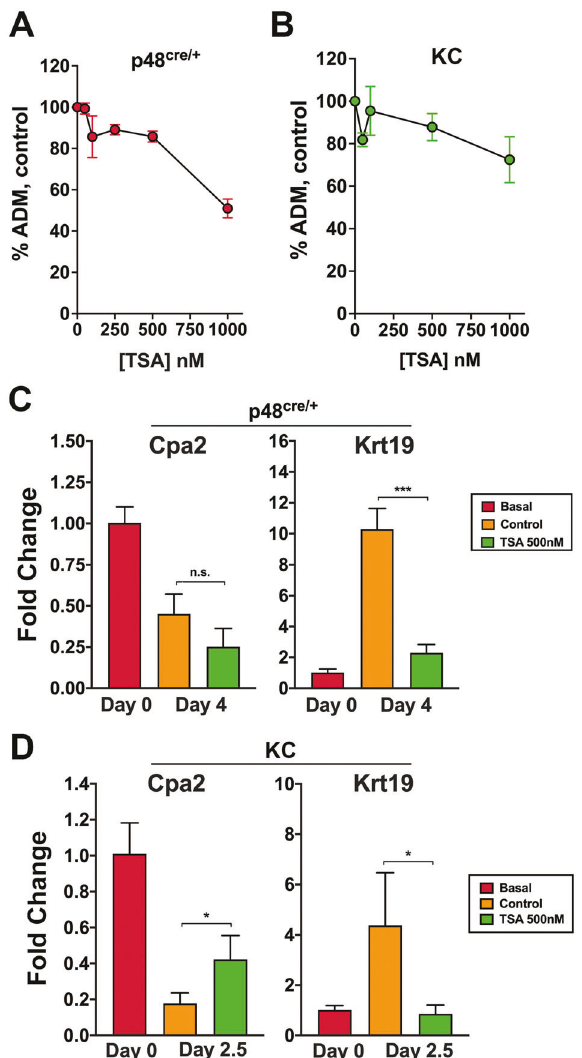
Fig. 2 The HDAC inhibitor TSA attenuates ADM. p48 Cre/ + ( A ) and KC ( B ) primary mouse pancreatic acini were treated with TSA for 3 and 2 days, respectively, and the amount of ADM was calculated microscopically. p48 Cre/ + ( C ) and KC ( D ) acinar cultures were exposed to 500 nM TSA or untreated control for 3 and 2 days, respectively, and the expression of Cpa2 and Krt19 was determined using qRT-PCR. Mean ± SD from triplicate treatments. * P < 0.05; *** P < 0.001, n.s. not signi fi